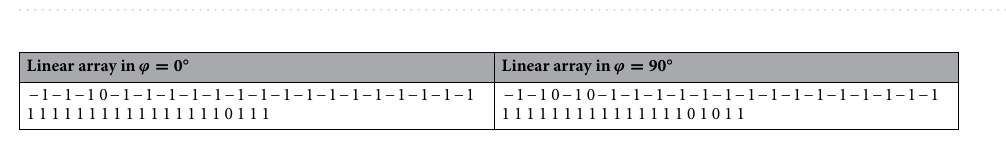
Table 4. Relative excitations vector for the linear arrays used in the design of the planar separable distribution reported in Fig. 2.